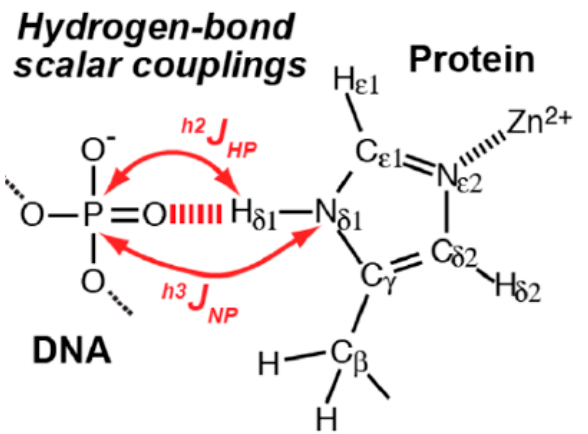
Figure 17. Hydrogen bond scalar coupling involving a phosphate and a histidine. Taken from [71] with permission from the American Chemical Society. with permission from the American Chemical